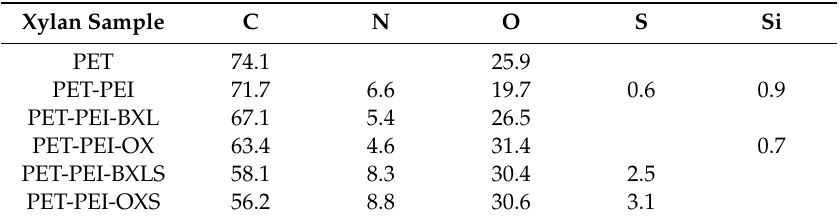
Table 3. Surface elemental compositions (at. %) of PET model films functionalized with PEI and non-modified and sulfated